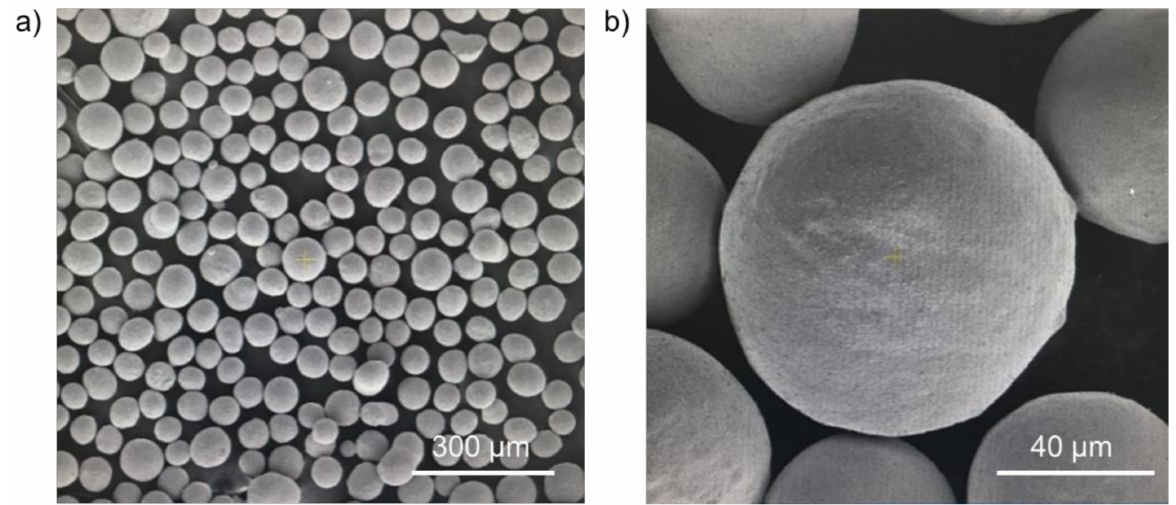
Figure 15. SEM images of industrial CNFT-1 catalyst at ( a ) low magnification and ( b ) high magnification.